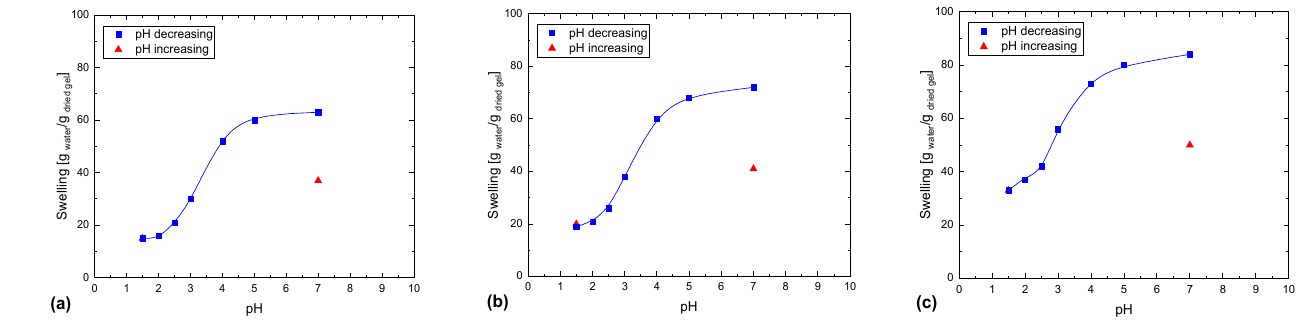
Figure 11. pH-dependent swelling of 5% CMC hydrogels formed with 5% PEGDA, 25 kGy; HPC% content: ( a ) 0, ( b ) 5, and ( c ) 10. Table 2. Change in DS of the HPC and CMC hydrogels formed with or without PEGDA in response to an increase in temperature (room temperature to 55 °C ) or a decrease in pH (7 to 1.5).